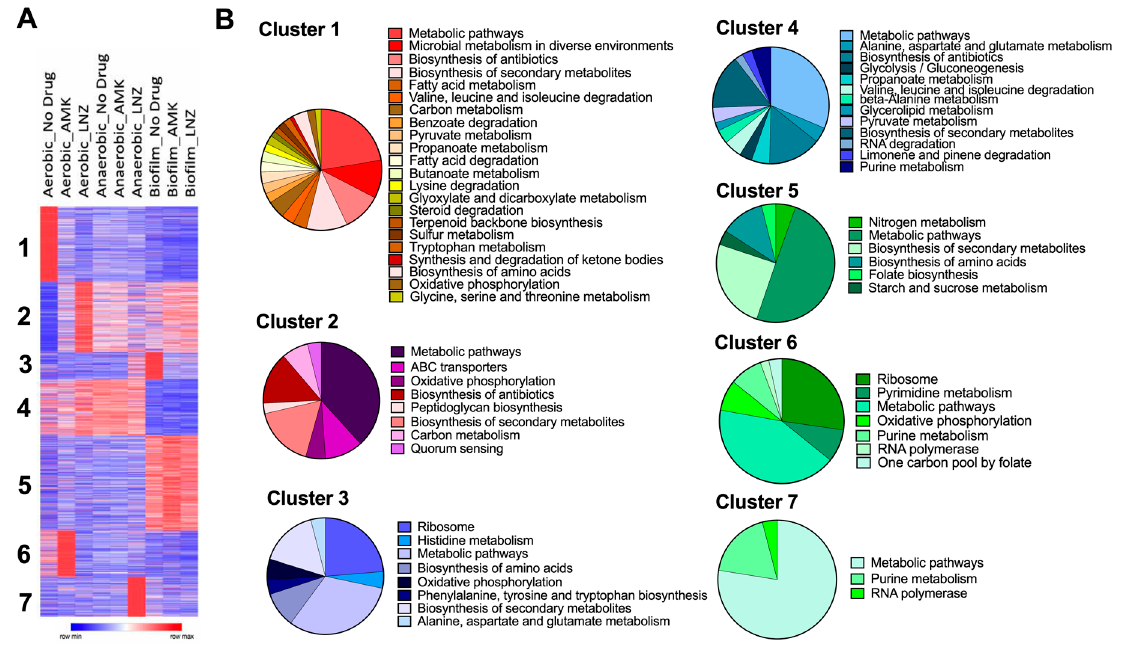
Figure 4. The heatmap and clustering analysis. ( A ) The heatmap demonstrates clustering of different protein groups under stress conditions with various enrichment levels in antibiotic or no antibiotic treatment groups. The color reflects the degree of change. K-means clustering was performed for 3722 genes across all studied groups (adjusted p -value < 0.05), and K = 7 was determined as an optimal number. ( B ) Pie charts correspond to 7 clusters of the heat map and display enriched metabolic pathways of the KEGG (Kyoto Encyclopedia of Genes and Genomes) database.